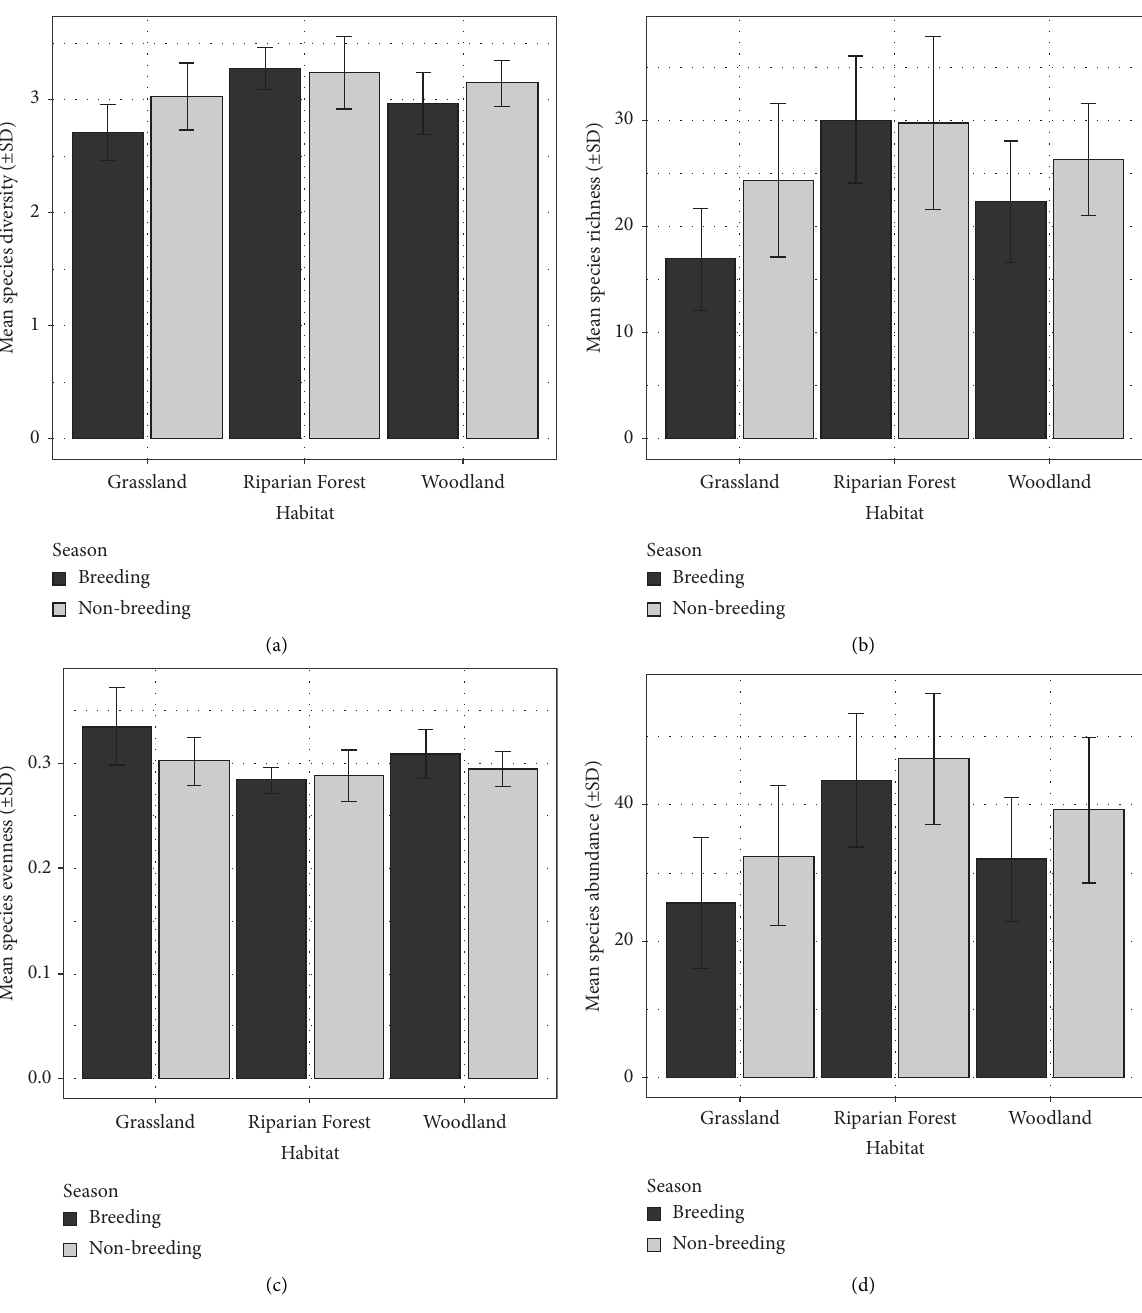
Figure 2: Variations in overall mean avifaunal diversity indices among habitat types in the MNP ((a) Shannon–Wiener diversity, (b) species richness, (c) evenness, and (d)